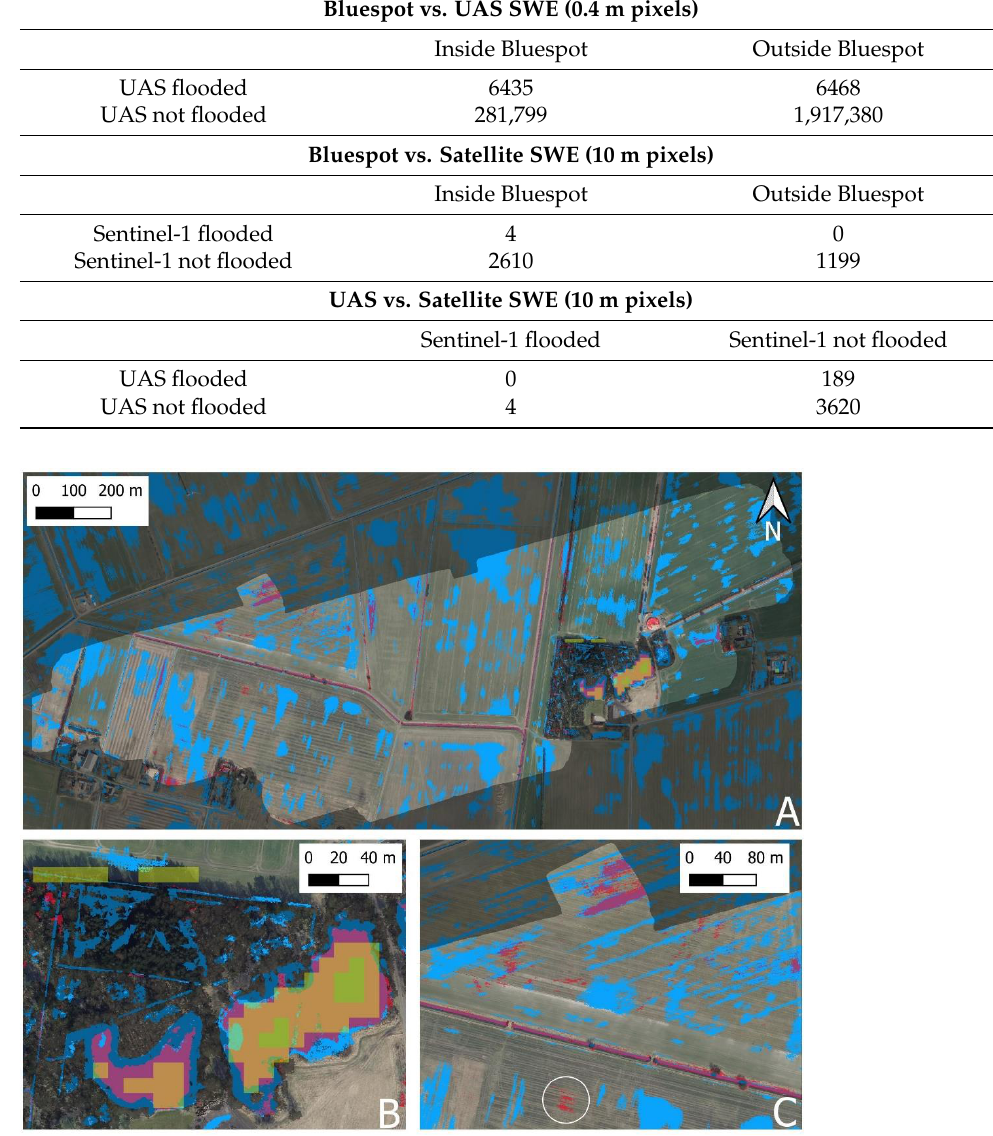
Figure 6. Bluespot areas (blue, threshold 10 mm), UAS SWE (red) and satellite SWE (green: Sentinel-1, 28-02-2022, yellow: Sentinel-2, 26-02-2022) for the Ø land area (A) and two zoomed-in sub-areas (B,C). Background is spring airborne imagery and grey shading indicates areas without UAS flooding status. White circle highlights patch of UAS-flooded pixels outside Bluespot area. Table 2. Contingency table for the Ø land area.